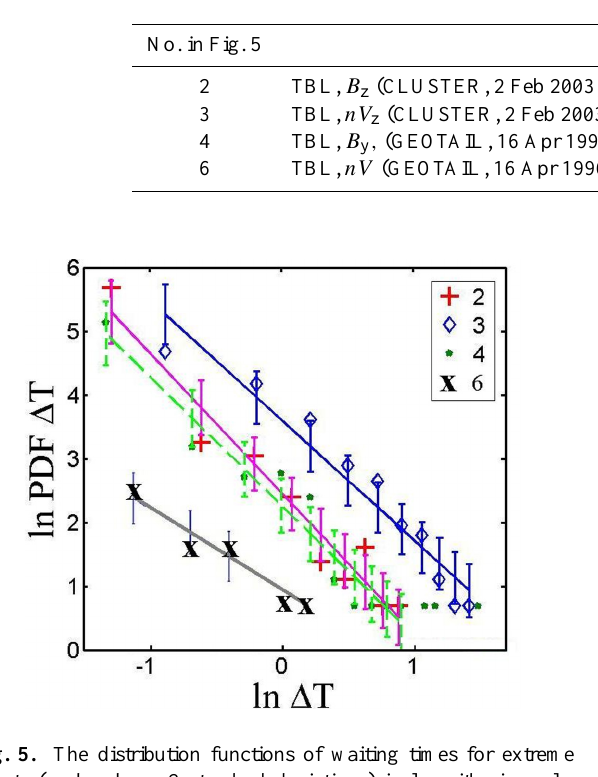
Table 1. Scaling η for Fig. 5 (see also Savin et al., 2011).